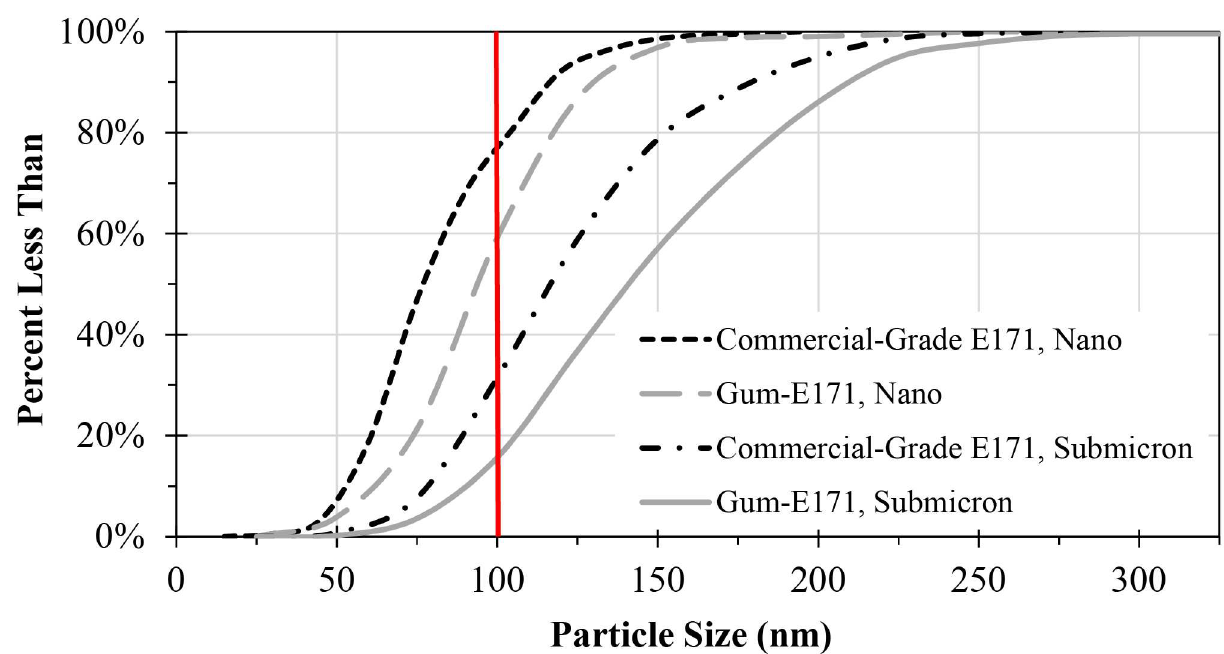
Fig 4. Cumulative size distribution for TEM primary particle analysis of commercial-grade E171 and gum-E171 nano- and submicron-enriched fractions. Solid vertical line indicatesnanoparticle size cutoff using the 100 nm definition.